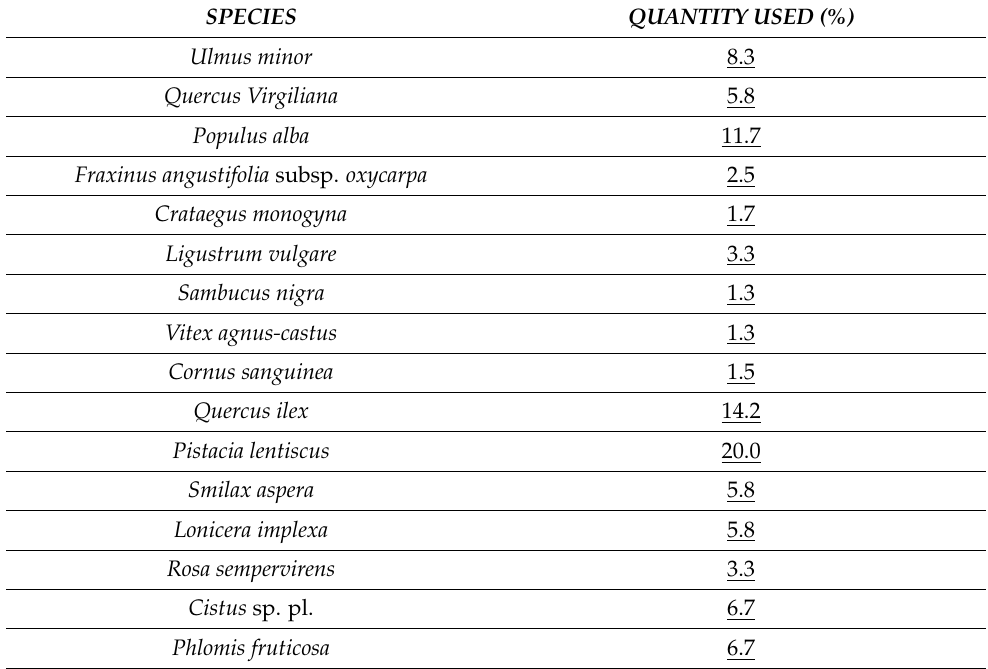
Table 3. Percentage of species used for the restoration of the riparian forest and Mediterranean